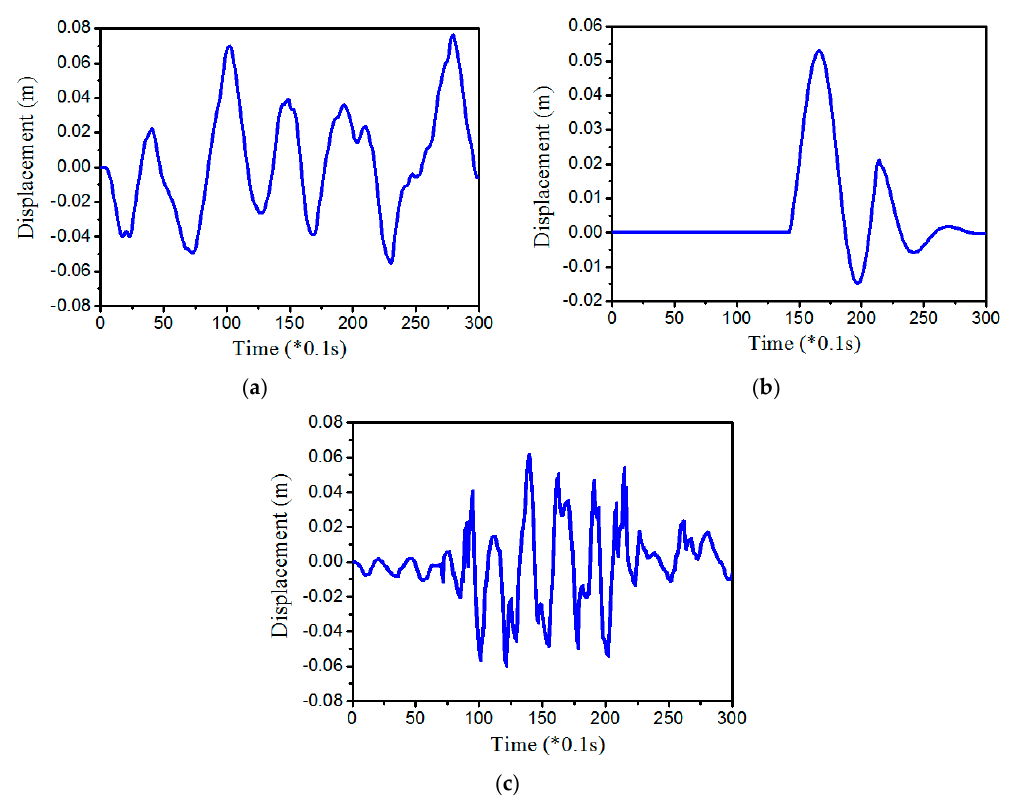
Figure 3. Excitation signals: ( a ) random-bump road; ( b ) regular-bump road; ( c ) random step wave road. Table 1. Parameters of seat suspension system.